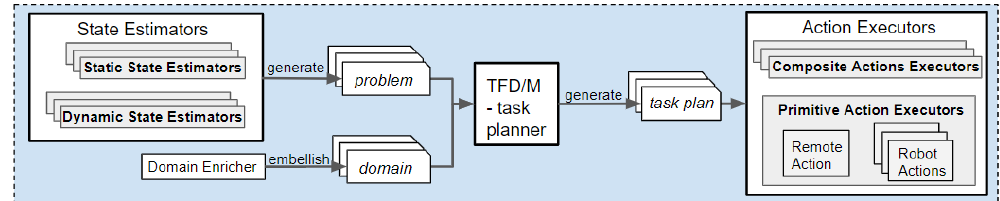
Figure 3. The continual planner calls the State Estimators (i.e., Static State Estimators and Dynamic State Estimators) and Domain Enricher to generate the PDDL problem and domain based on observations from the robot and smart environment. The TFD/M planner generates a task plan that contains primitive actions, to be executed by the robot and IoT actuators and composite actions.